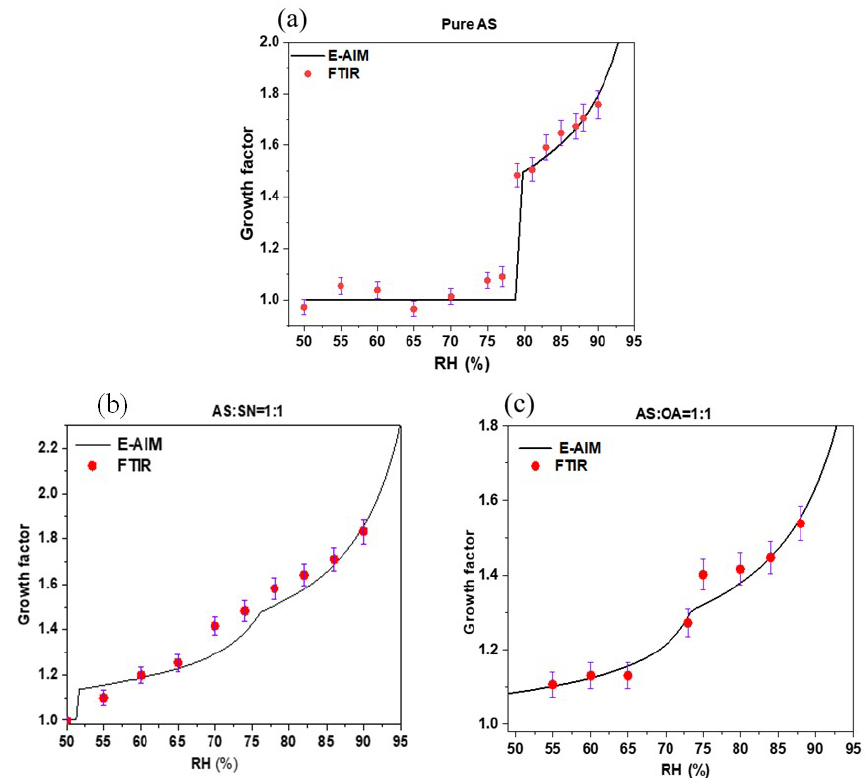
Figure 6. The same as Fig. 5 but for